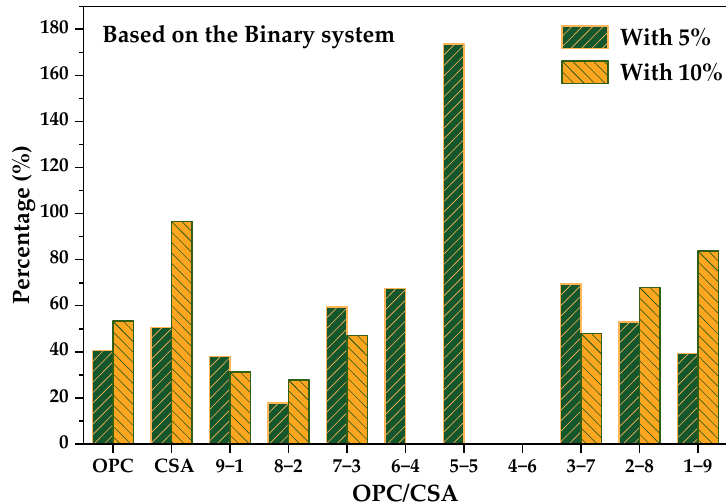
Figure 10. Drying shrinkage values of different pastes: ( a ) with 5% CS; ( b ) with 10% CS.